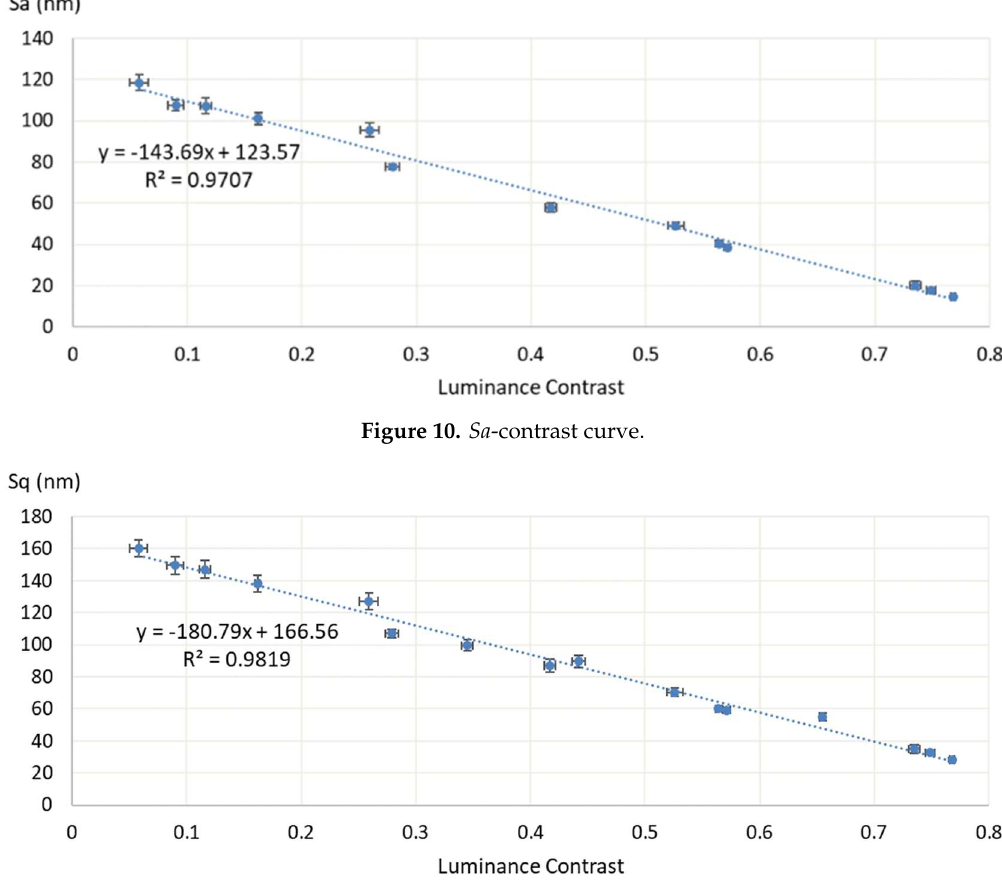
Figure 11. Sq -contrast curve.